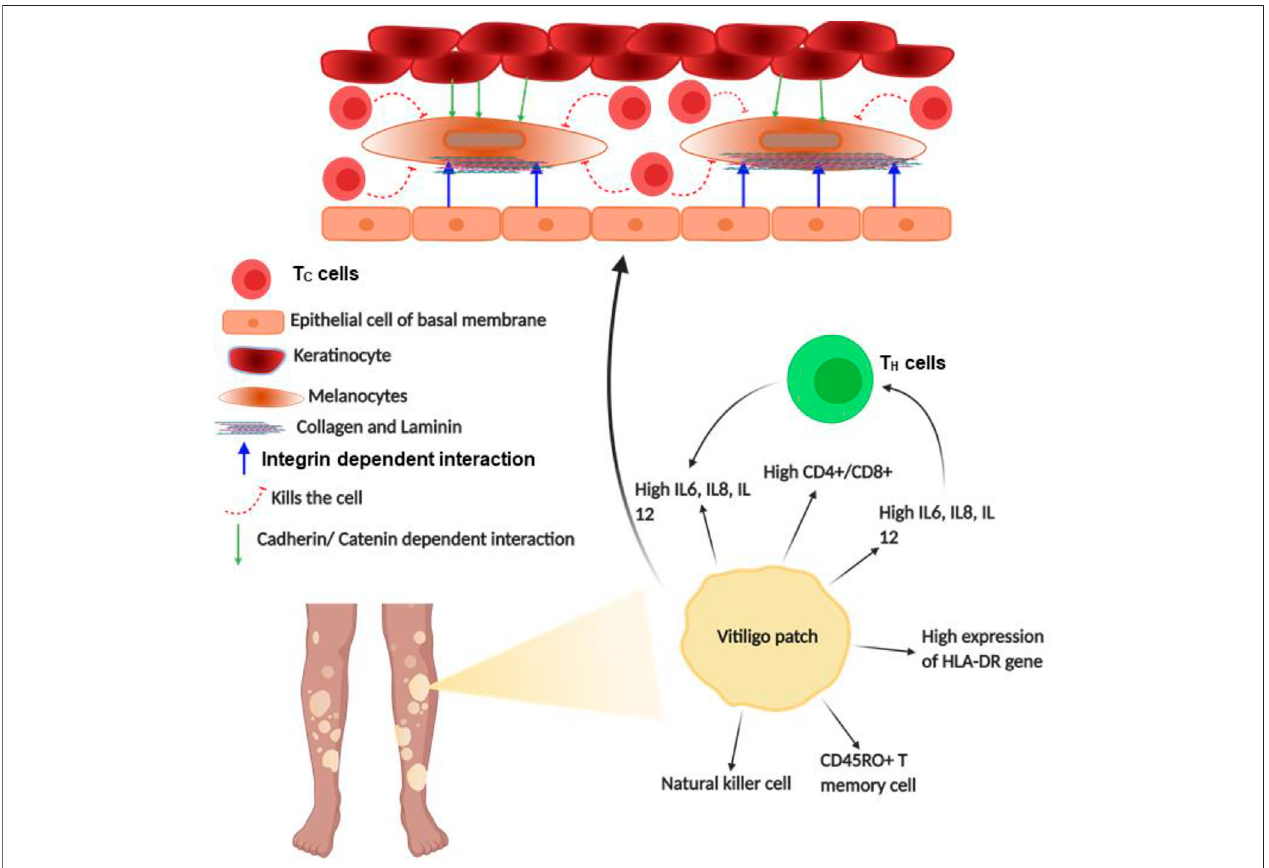
FIGURE 7 | Schematic diagram of vitiligo pathophysiology: the fi gure provides a schematic diagram of how vitiligo develops and what points of this disease are regulated by integrin. Blue arrows denote signaling or mechanism being regulated by integrins.